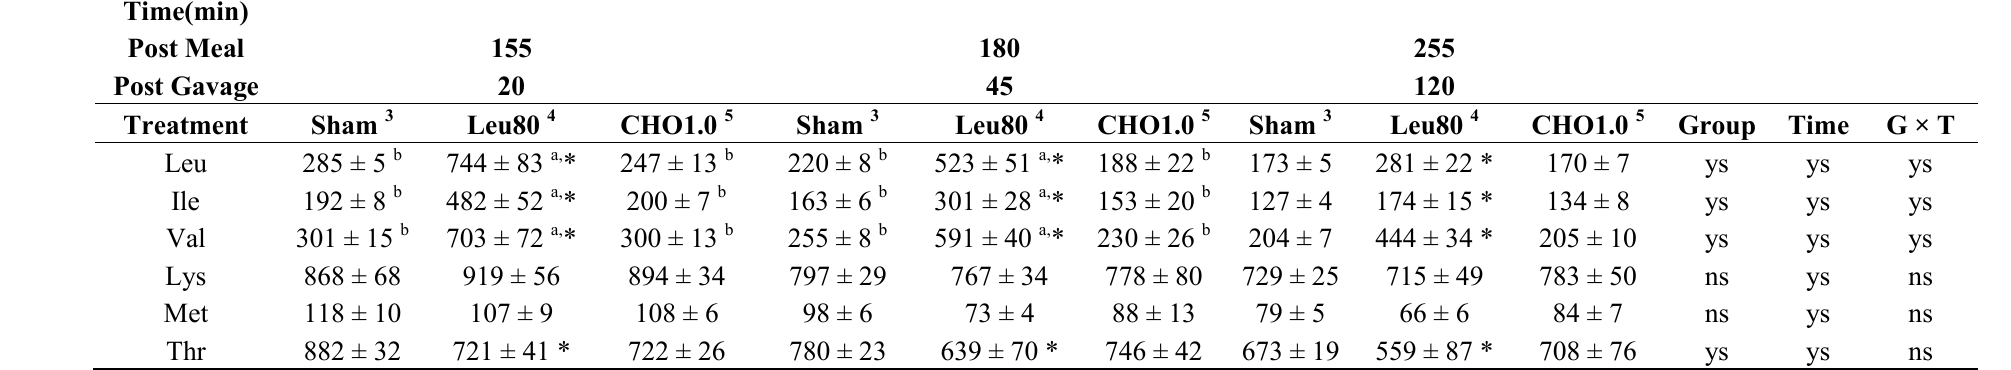
Table 5. Post-gavage plasma amino acid responses for Experiment 2 1, 2